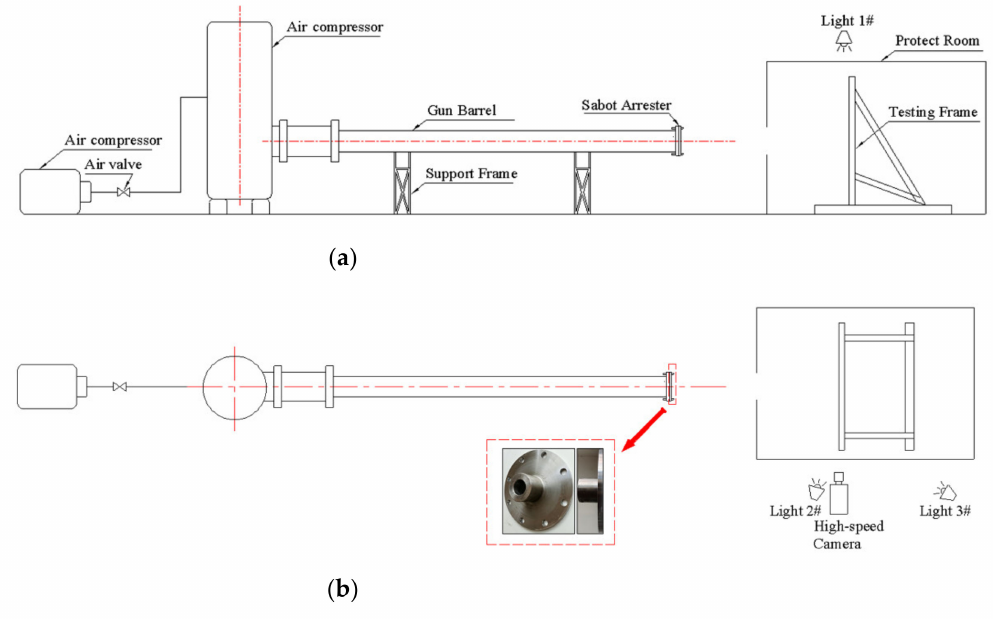
Figure 1. Experimental setup of the ( a ) front view and ( b ) top